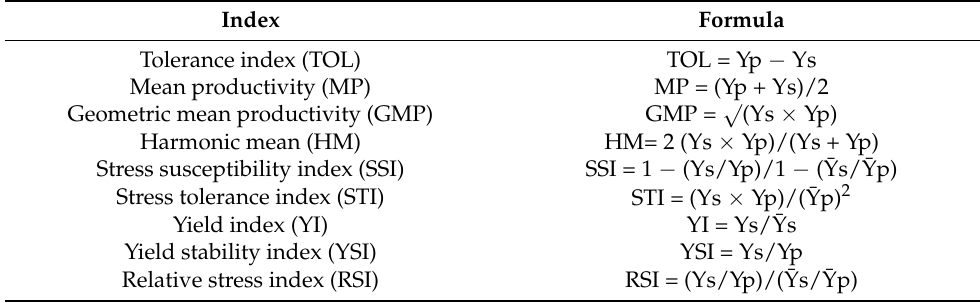
Table 1. Stress indices calculated with the iPASTIC software with corresponding formulas [60]. Index Formula Tolerance index (TOL) TOL = Yp − Ys Mean productivity (MP) MP = (Yp + Ys)/2 Geometric mean productivity